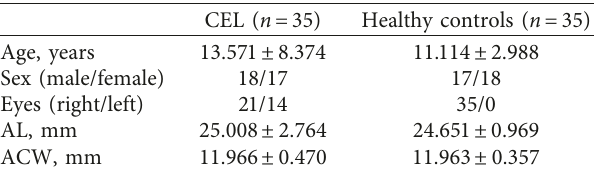
Figure 1: Diagram of the scan performed in CEL patients. (a) The scan was performed on the dislocated lens axis. (b–e) Different angle parameters of the dislocated lens side (wider side) and the contralateral side to the dislocated lens side (narrower side), and the ratio index of angle parameter was defined as the angle parameter value of the narrower side to that of the contralateral side. Table 1: Demographics and ocular biometric characteristics of